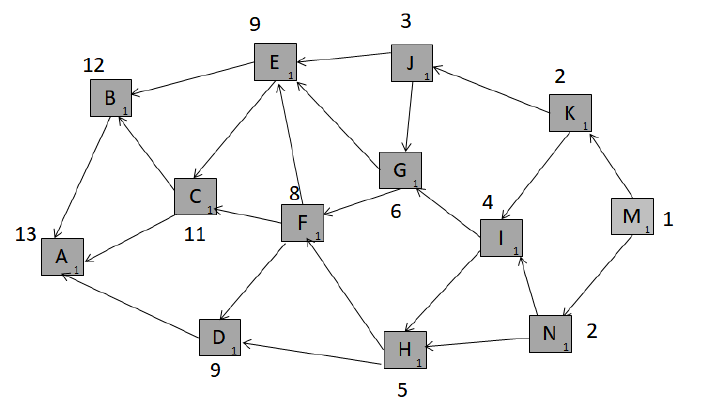
Figure 10. A snapshot of tangle with direct and cumulative weight of the sites. The boxes represent transactions; the small number in the corners of each box denotes own weight, and the bold number on top denotes the cumulative